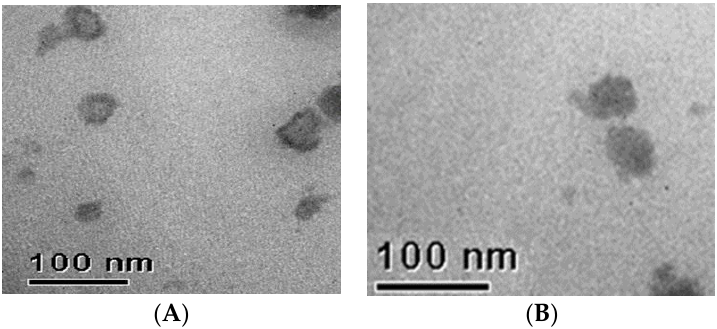
Figure 3. Transmission electron microscopy (TEM) images of solid lipid nanoparticles A ( A ); and lipid nanoparticles CEO3 ( B ).